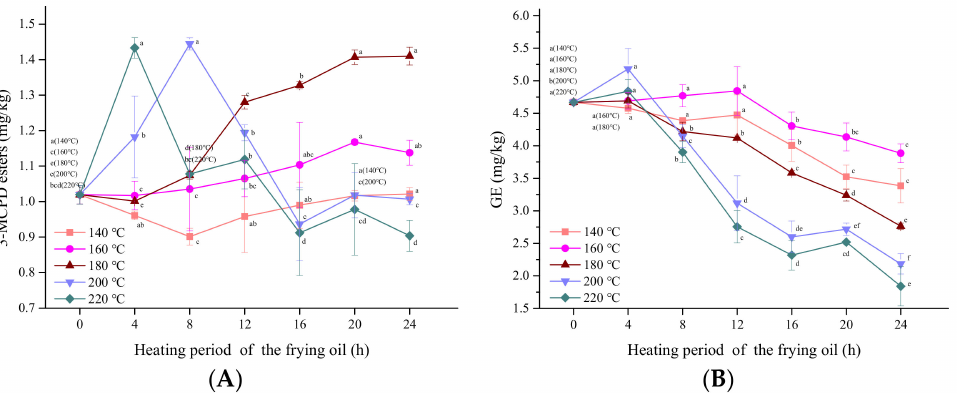
Figure 3. The content of ( A ) MCPDE and ( B ) GE fried oils of different heating periods after frying chicken breast under 140 ◦ C, 160 ◦ C, 180 ◦ C, 200 ◦ C, and 220 ◦ C, respectively. Within each line, points with different letters are significantly ( p < 0.05) different from each